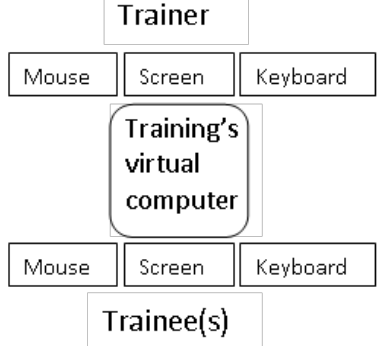
Fig. 2. Model of virtual computer for mastering of software product.